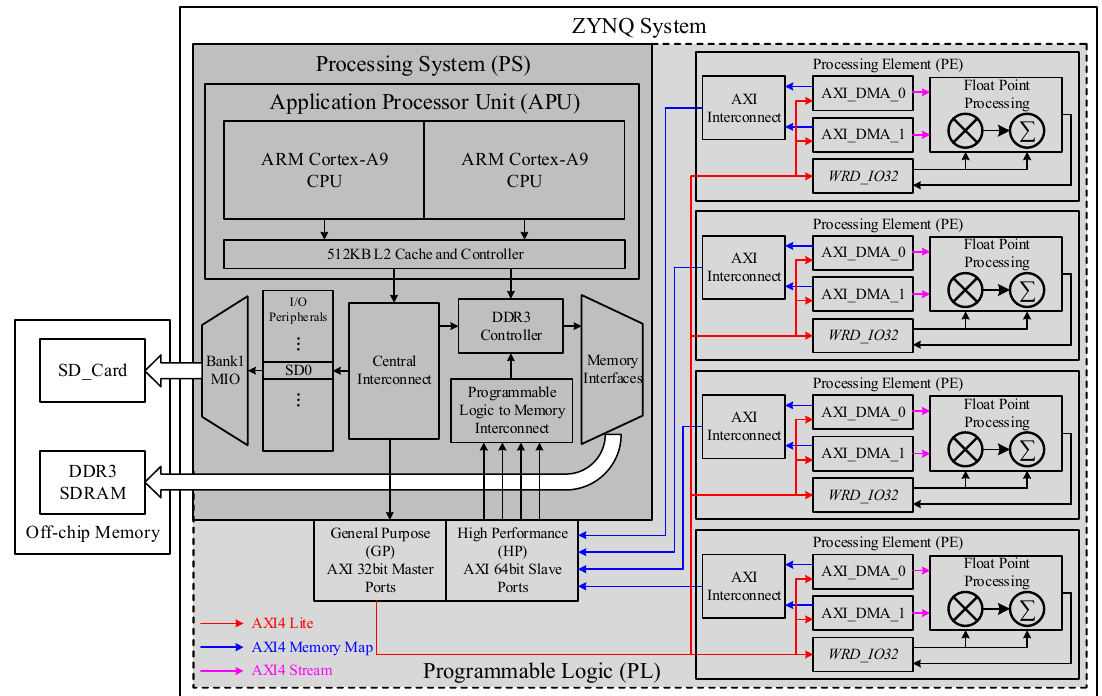
Figure 4. Field programmable gate array (FPGA) architecture of system implementation. Electronics 2019 , 19 , x FOR PEER REVIEW